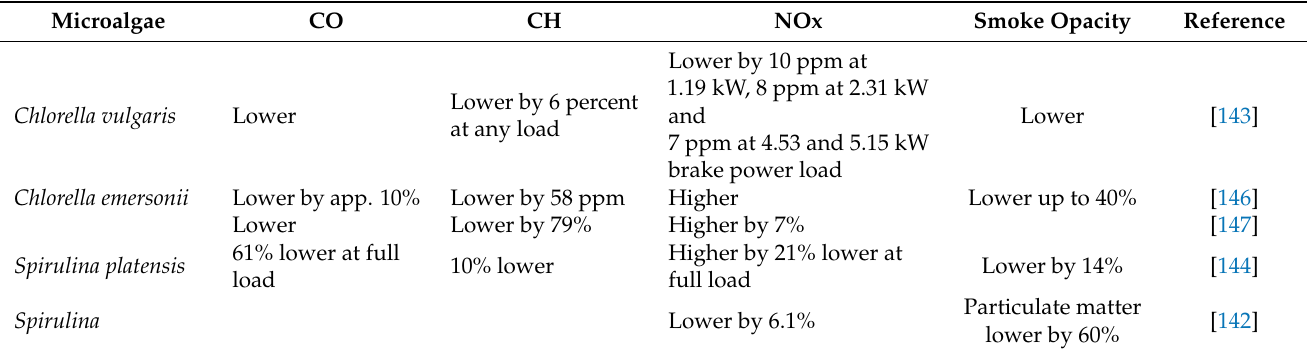
Table 12. Engine emissions using microalgae biodiesel compared to mineral